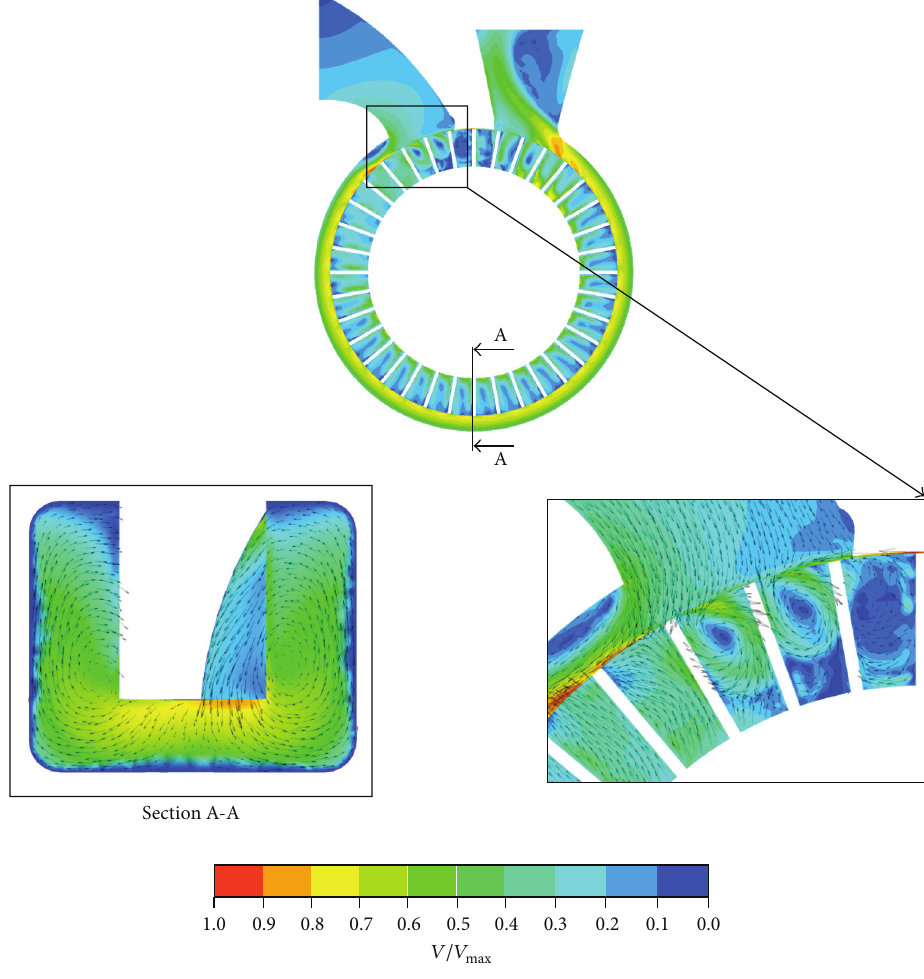
Figure 13: Velocity contour at design flow